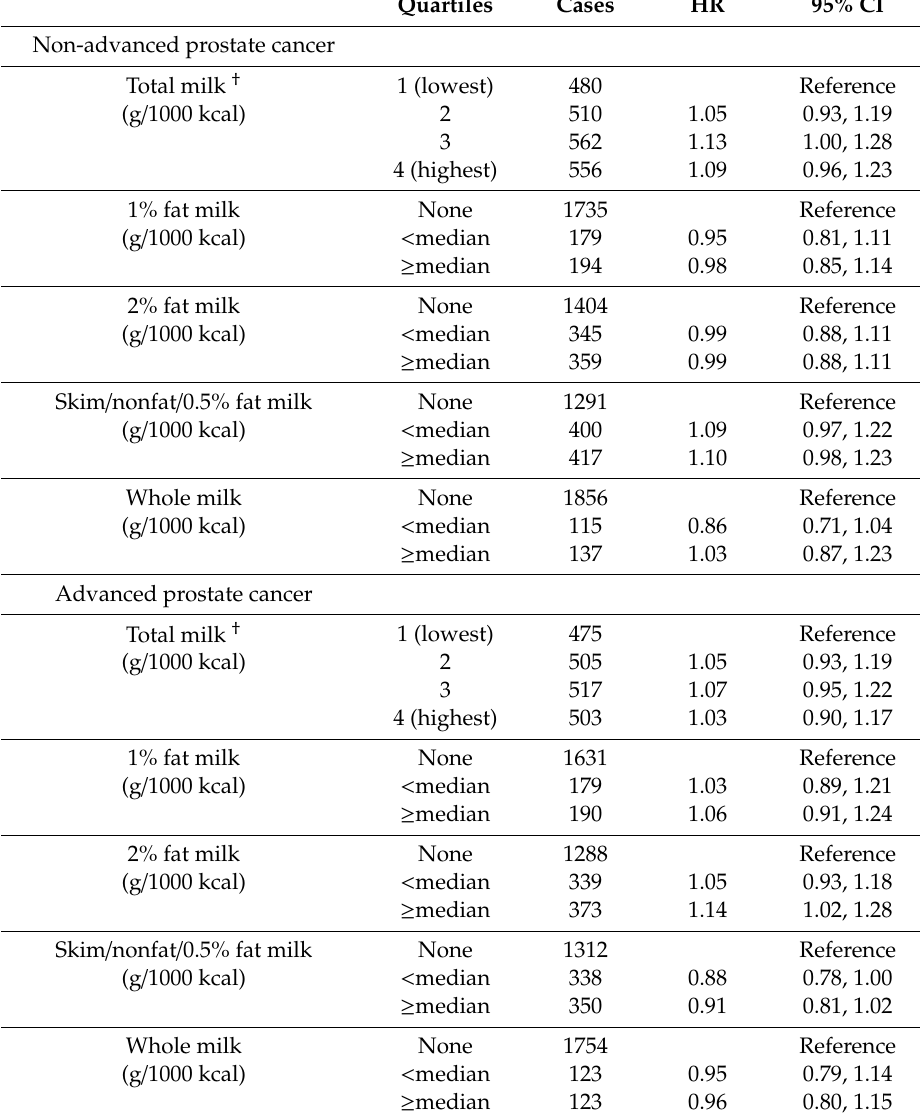
Table 5. Risk of prostate cancer by milk intake stratified by advanced or non-advanced prostate cancer